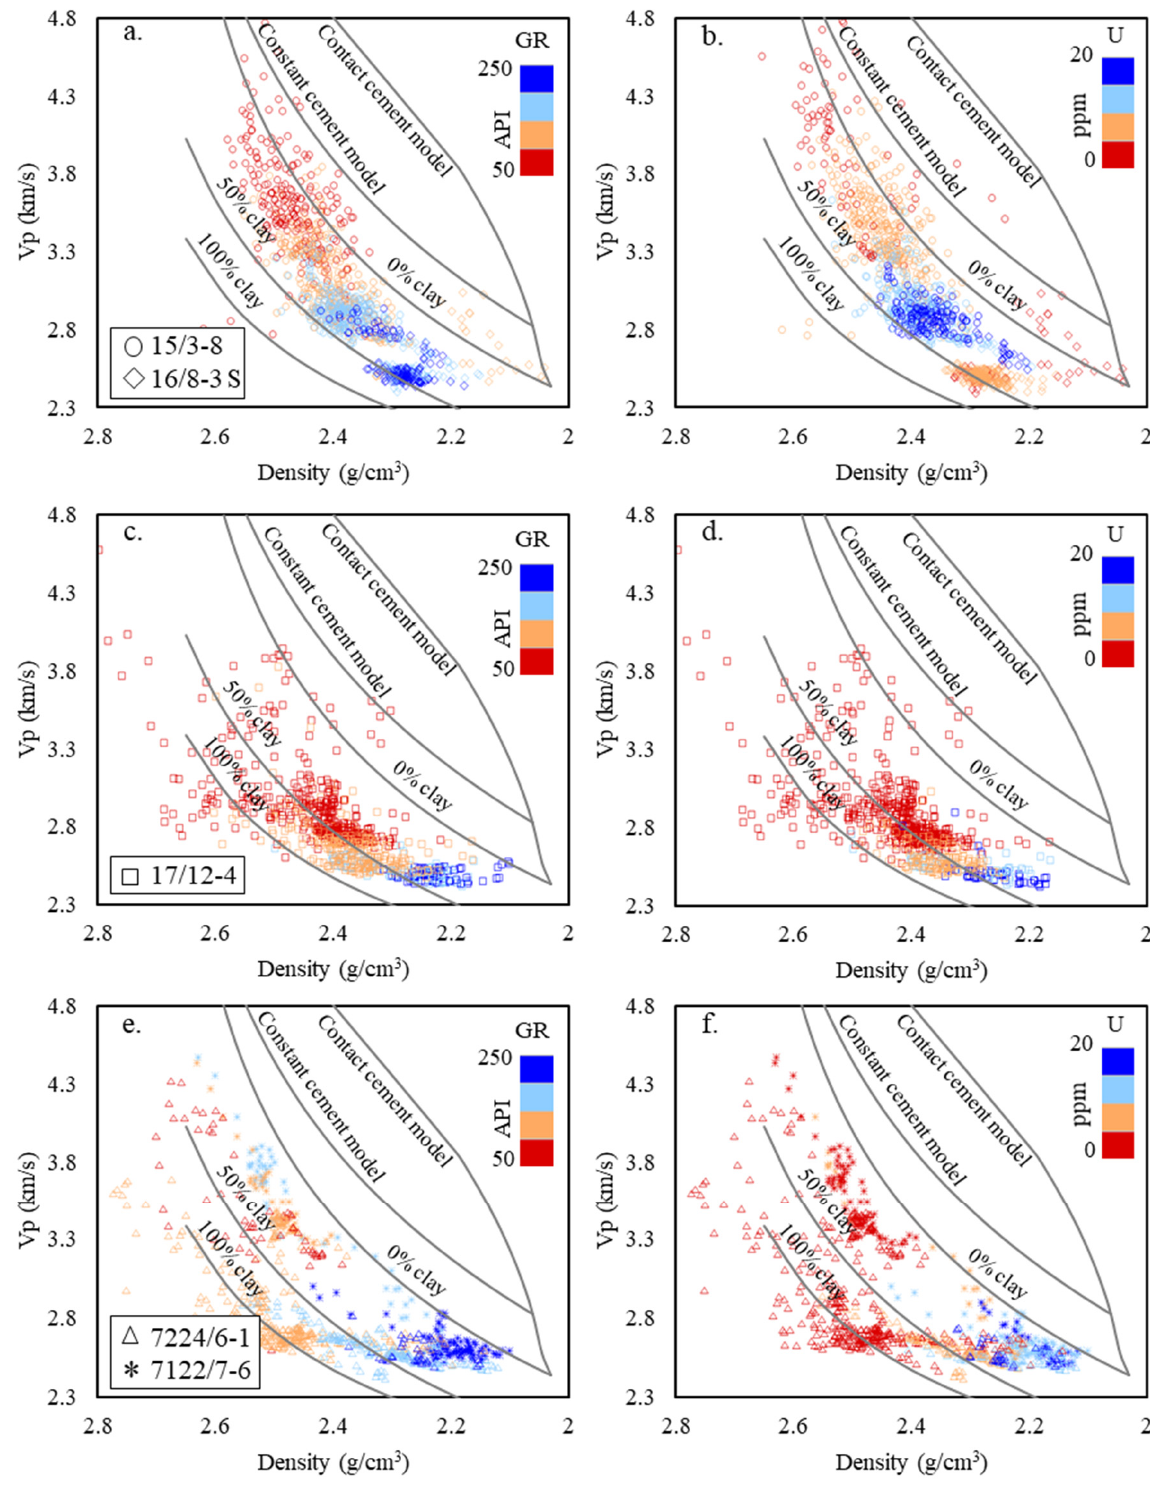
Figure 6. Velocity versus density cross-plots of Draupne Formation from 15/3-8 and 16/8-3 S color- coded with GR ( a ) and uranium content ( b ), Tau and Egersund formations from 17/12-4 color-coded with GR ( c ) and Uranium content ( d ), and Hekkingen and Fuglen formations from 7224/6-1 and 7122/7-6 wells color-coded with GR ( e ) and Uranium content ( f ). The reference curves (RPTs) are adapted from Avseth et al. [65].